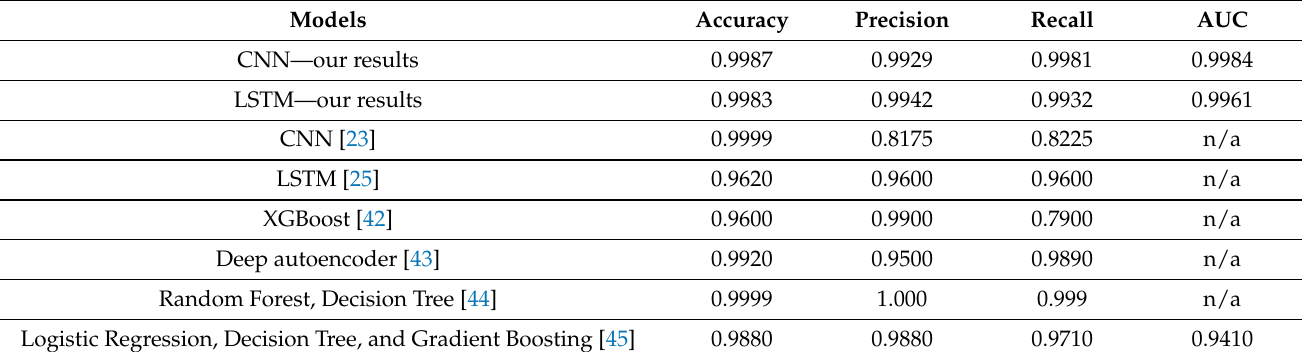
Table 13. Comparison with other works available in the